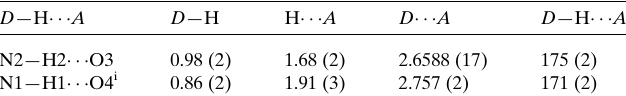
Table 2 Hydrogen-bond geometry (A˚ , (cid:4) ) for 5-MeO-DPT fumarate.